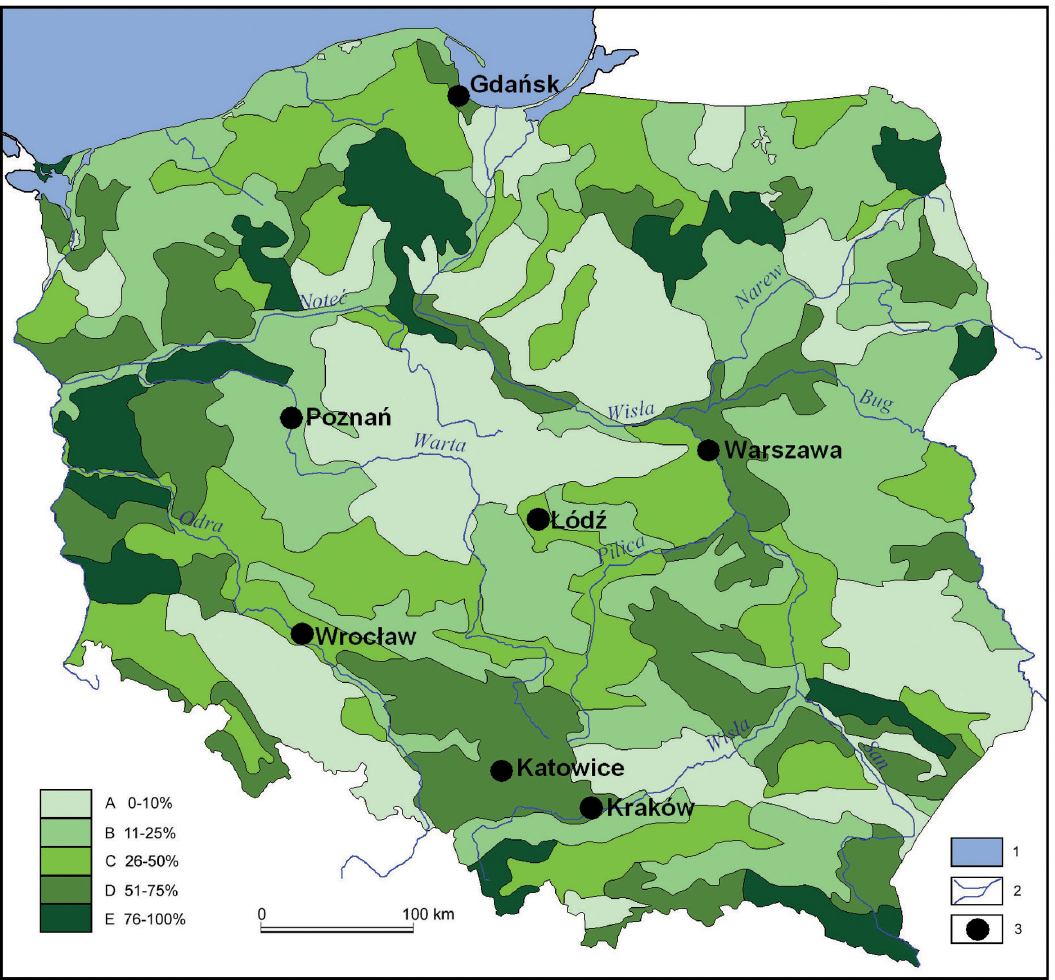
Fig. 2. The degree of landscape opening/enclosure in Poland in the 30s of the 20th century: A – open landscape (0–10%); B – nearly open landscape (11–25%); C – half-open landscape (26–50%); D – considerably enclosed landscape (51–75%); E – enclosed landscape (76–100%); 1 – Baltic Sea, 2 – river network, 3 – larges